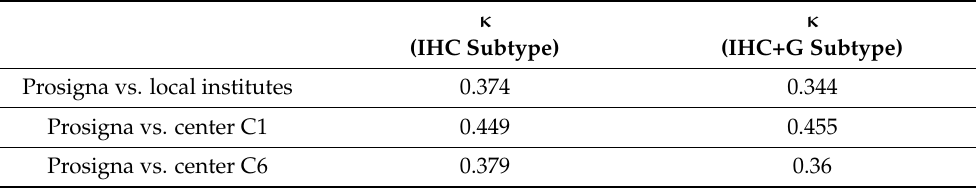
Figure 3. Distribution of Prosigna® risk groups across local surrogate A) IHC subtypes and B) IHC+G subtypes. IHC = immunohistochemistry; IHC+G = immunohistochemistry + tumor grade; LumA = Luminal A; LumB = Luminal B. 2.6. Influence of Prosigna® Assay Result on Treatment Recommendation Looking at the distribution of tumor board recommendation within the different Prosigna® subtypes, chemotherapy + endocrine therapy was recommended to 44.2% (23/52) of Prosigna® Luminal A cases and to 88.6% (39/44) of Prosigna® Luminal B cases. The two cases with Prosigna® Basal-like (n = 1) and Prosigna® HER2-enriched (n = 1) IBC were both recommended towards adjuvant chemotherapy + endocrine therapy (Figure 4).